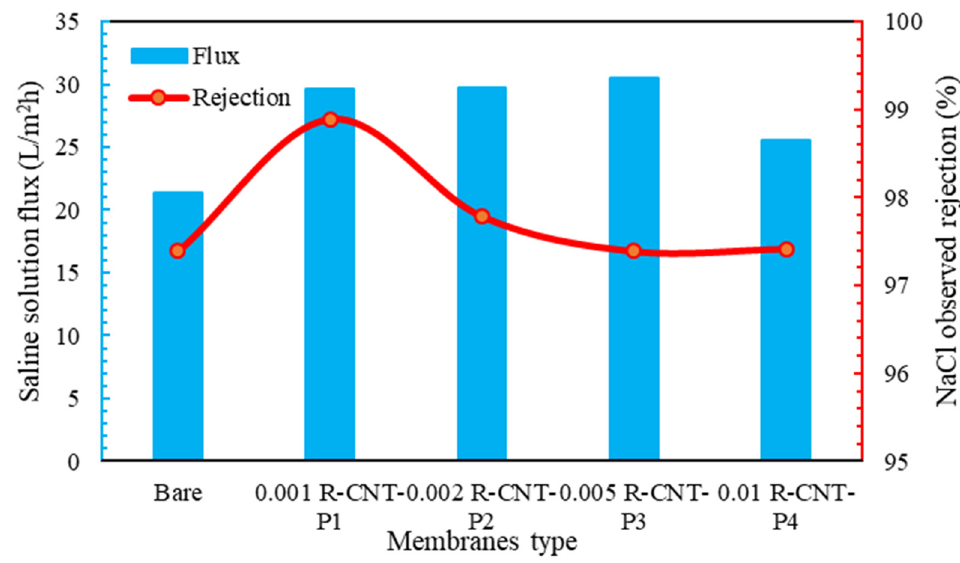
Figure 6. Flux and percent salt rejection for raw